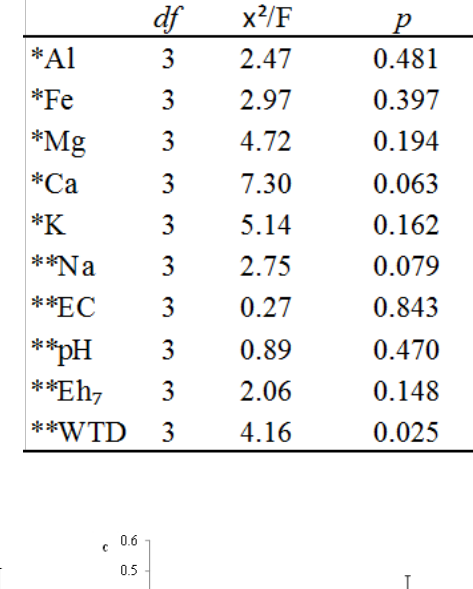
Table 4. ANOVA (*) and Kruskal-Wallis (**) for water chemistry variables. Calculations are based on average values for each site over all management classes.